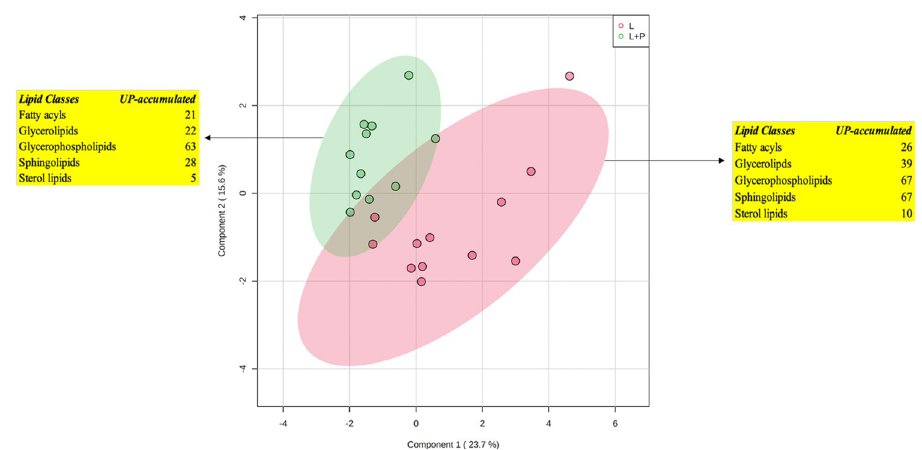
Fig 5. sPLS-DA score plot considering the comparison "L" vs "L+P" diets. The discriminant and up-accumulated lipid classes for each group are also provided.